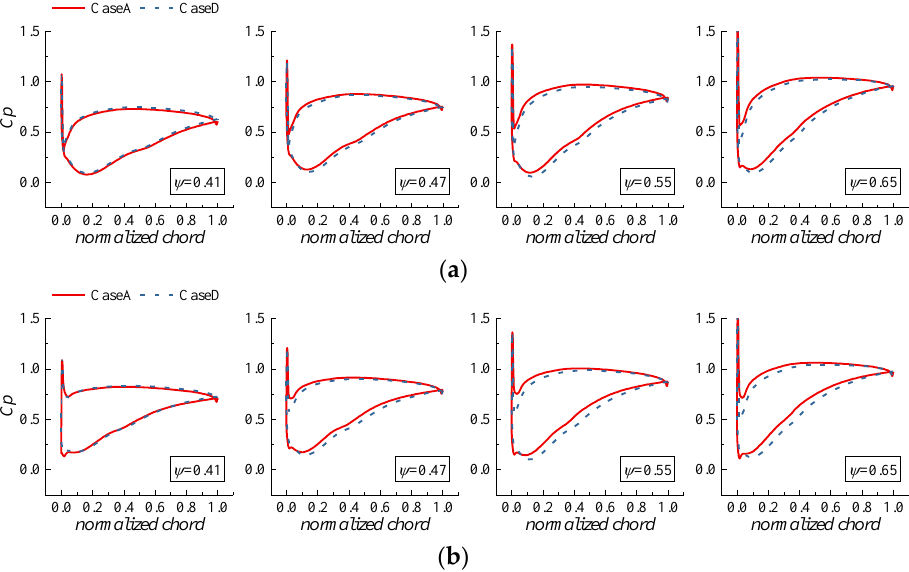
Figure 18. The distribution of stator static pressure rise coefficient at midspan at the near-stall condition: ( a ) design condition; ( b ) near stall condition.